Question: Write a single sentence explaining what this figure depicts.
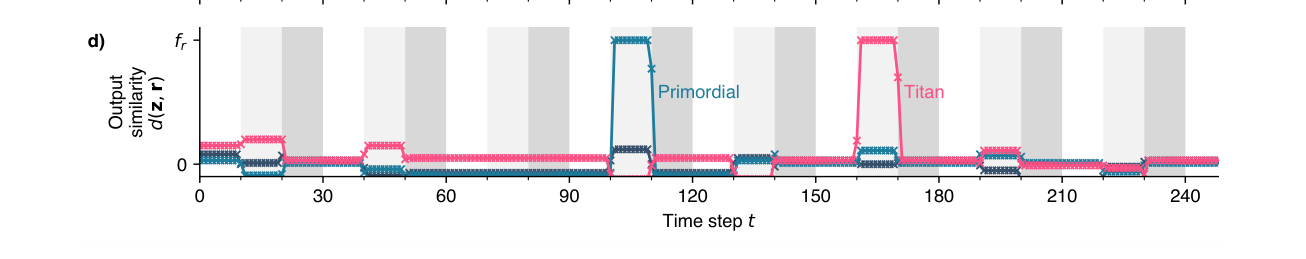
Answer: An attractor network transitioning through attractor states in a state-dependent manner, as a sequence of input stimuli is presented to the network. a) The input stimuli to the network, where for each unique stimulus (e.g. “father is” in the FSM to be implemented (Figure 1) a pair of hypervectors sa and sb have been generated. No stimulus, a stimulus sa, then a stimulus sb are input for 10 time steps each in sequence. b) & c) The similarity of the network state zt to stored node attractor states x ∈XAN and stored edge states e respectively, computed via the inner product (Equation 3). d) The similarity of the network state zt to the sparse output states r ∈RAN. All similarities have been labelled with the state they represent and the colours are purely illustrative. The attractor transitions shown here are explicitly state-dependent, as can be seen from the repeated input of the stimulus “father is”, which results in a transition to state “Kronos” when in “Hades”, but to “Uranu